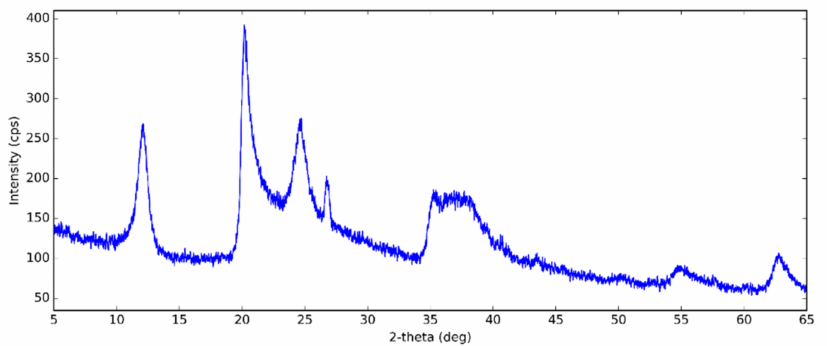
Figure 1. X-ray di ff raction (XRD) pattern of halloysite at the following XRD conditions: X-Ray: 40 kV, 30 mA. Scan speed: 3.0 degree /